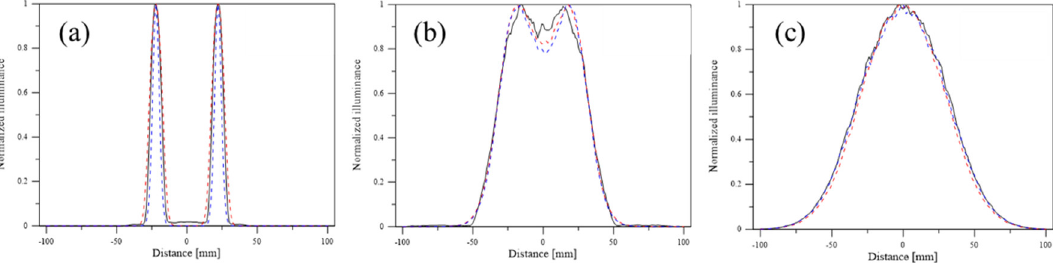
Figure 9. Light patterns simulation for the light source with 30 ° divergent angle at ( a ) 10, ( b ) 50, and ( c ) 100 mm distances.